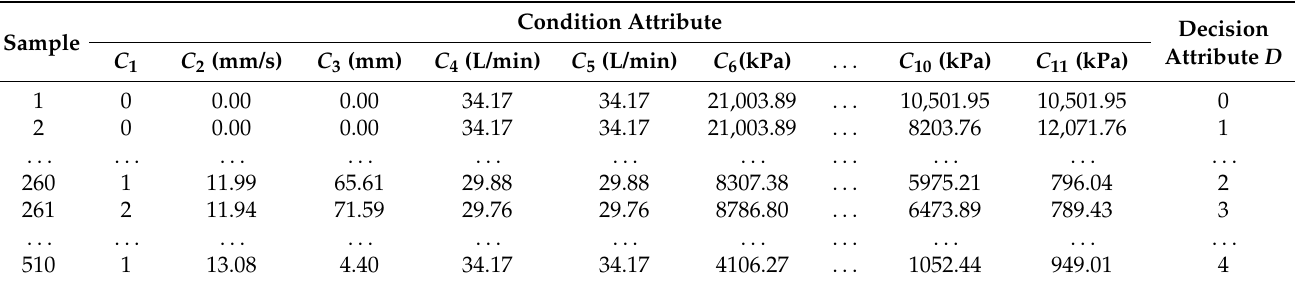
Table 2. The original fault decision